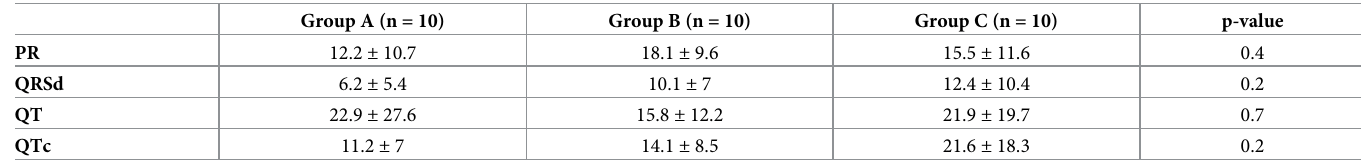
Table 2. Variance between Smartphone Monitor and 12-lead ECG parameters. There was no statistical difference in average absolute mean difference for interval mea- surements between groups.